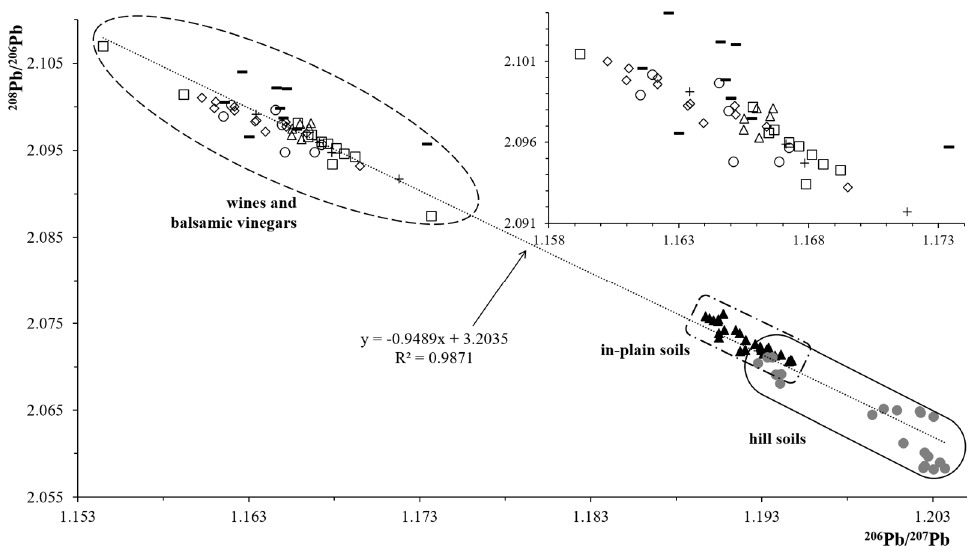
Figure 4. Plot of the 206 Pb / 207 Pb vs. 208 Pb / 206 Pb data for soil and wine samples. ( • ) Hill soils C, ( ) in-plain soils A and B, ( ) Lambrusco di Sorbara, SOR; ( ) Lambrusco Grasparossa, GRA; ( ) Lambrusco Salamino, SAL; ( ) Lambrusco Reggio Emilia, RE; ( ) Lambrusco Mantova, MN; and ( − ) italian balsamic vinegars [36].